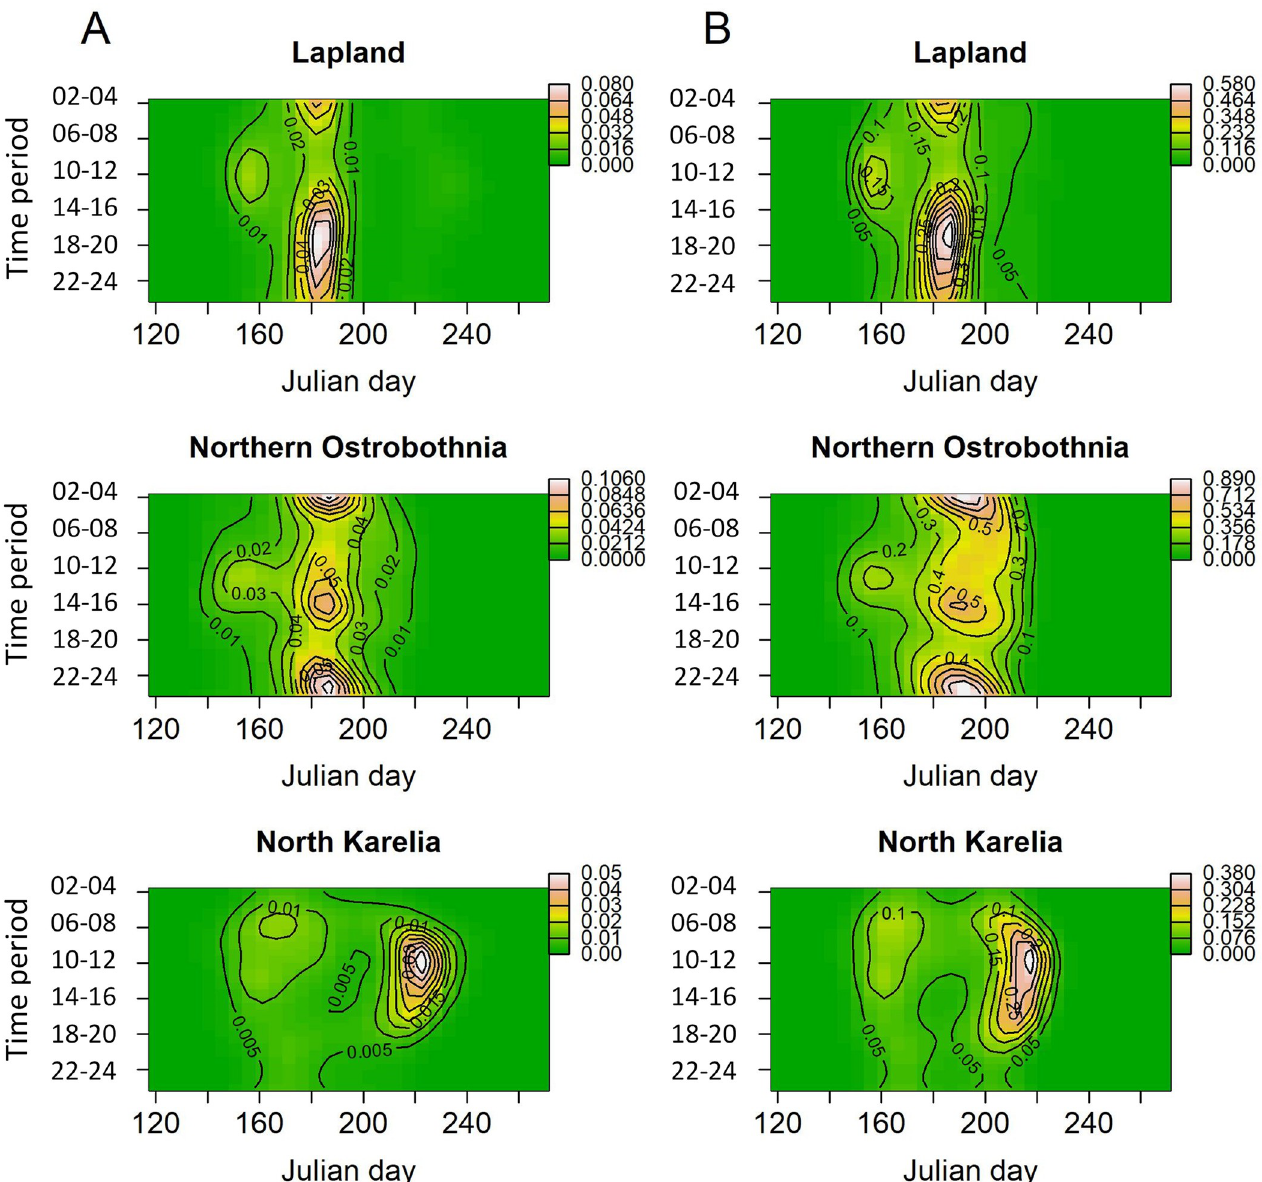
Fig 4. Combined seasonal and diel variation in taiga bean goose count. Model predicted mean count (per unit effort) of taiga bean geese with the interaction of Julian day and time period for the years a) 2018 and b) 2019. The uncertainty around the mean (95% CIs) is presented in S2 Fig.